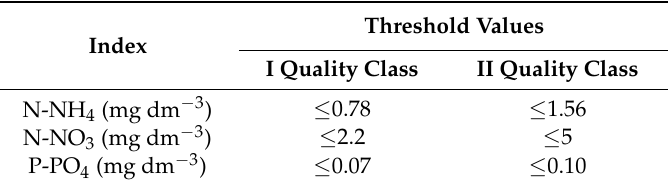
Table 6. The threshold values of water quality indices.